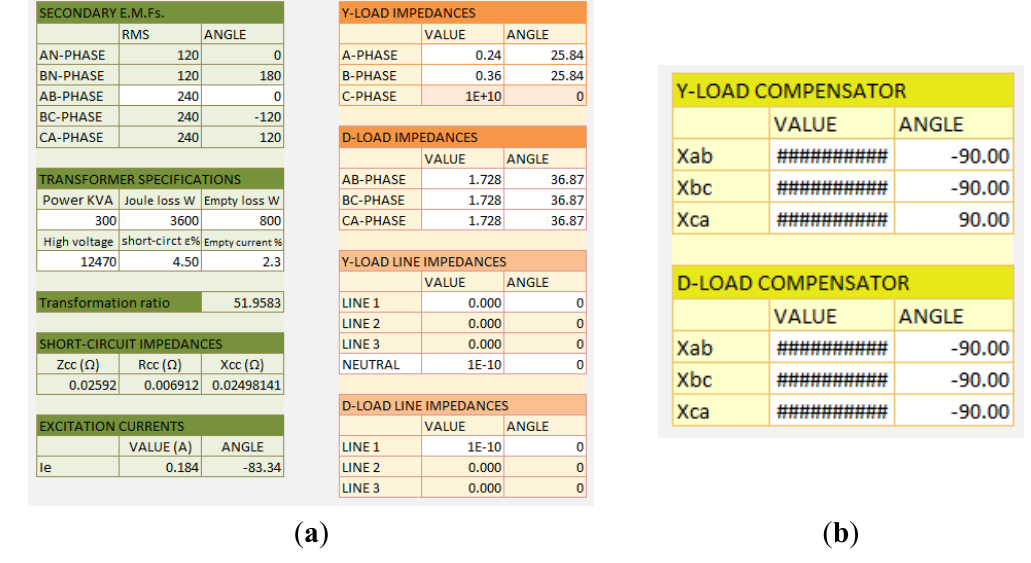
Figure 5. ( a ) Transformer, line and load specifications; ( b ) compensator insertion data area.